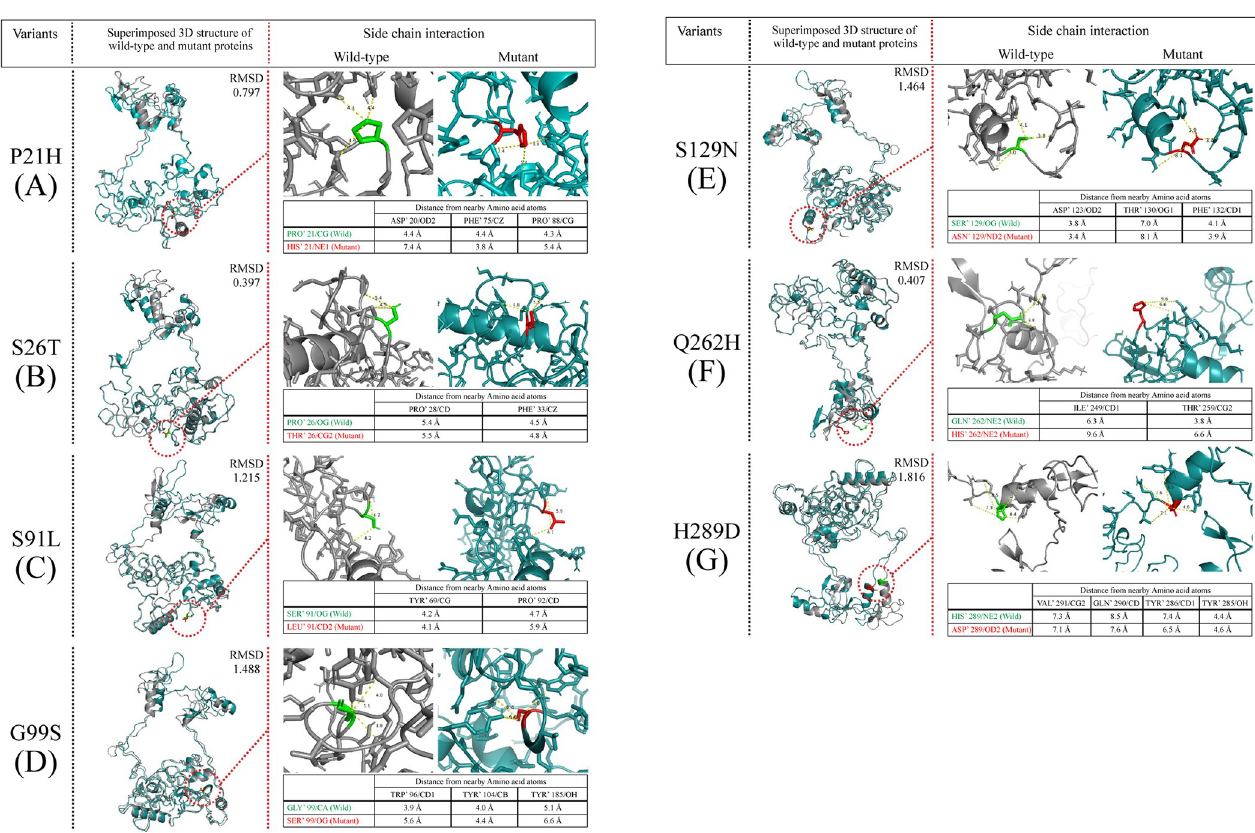
Fig 6. Evaluation of the effect of nonsynonymous mutations on the structure and interactions between side chain and neighboring residues. Among non- synonymous mutations, P21H (A) and S26T (B) mutations were found in the AD domain of the protein while Q262H (F) was within the C-ZF domain. Other mutations including S91L (C), G99S (D), S129N (E) and H289D (G) were found in regions outside the functional domains of GATA1 protein.